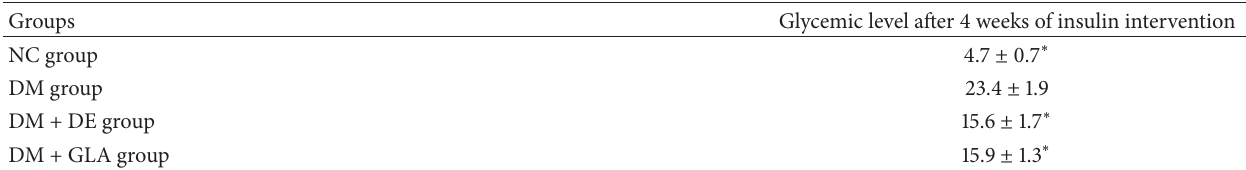
Table 3: Glycemic level (mmol/L) after 4 weeks of insulin intervention ( 𝑥 ± 𝑠 ).